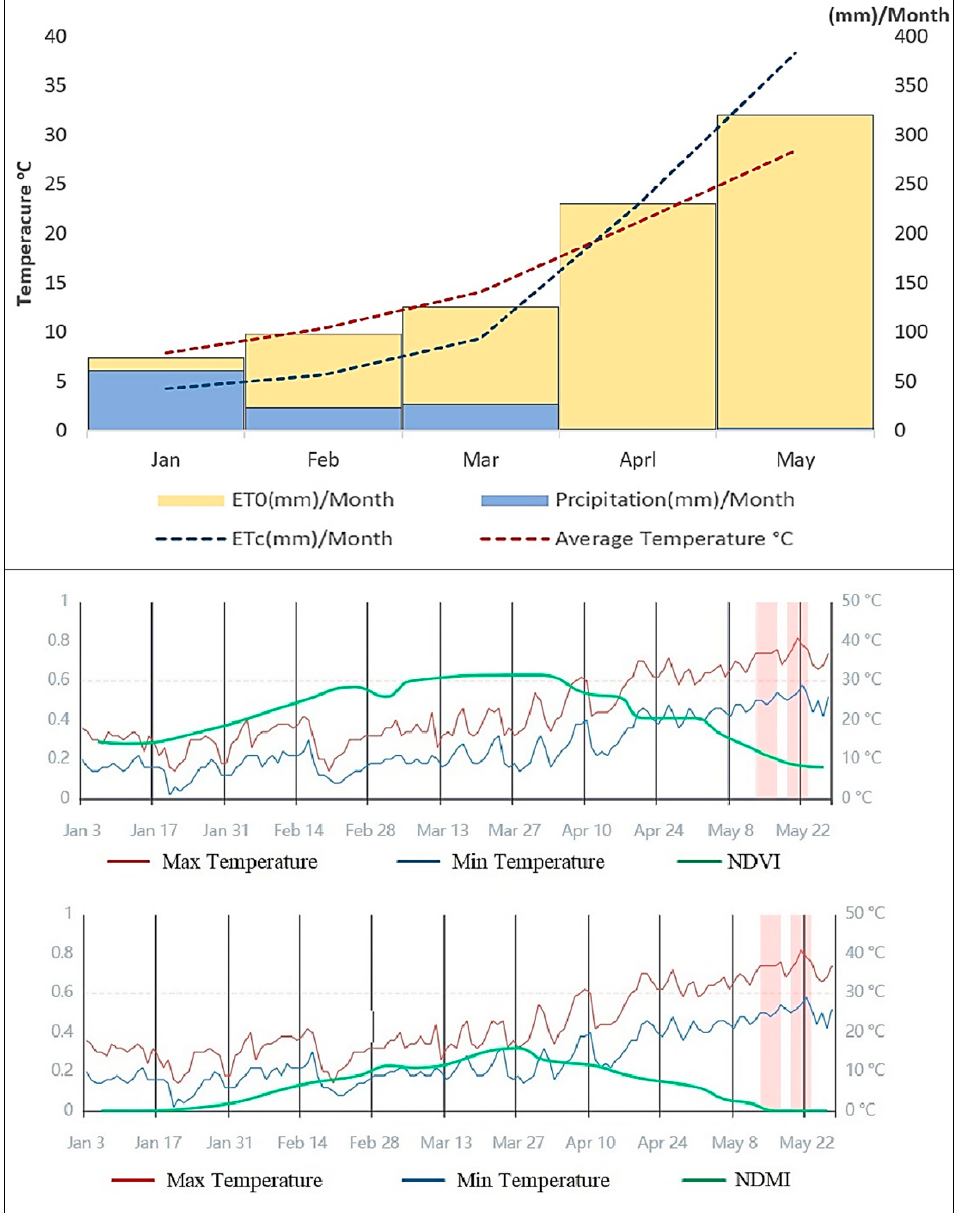
Figure 9. Monthly Precipitation, ETo, ETc, NDVI, NDMI, Average Temperature in study area recorded in 2021.